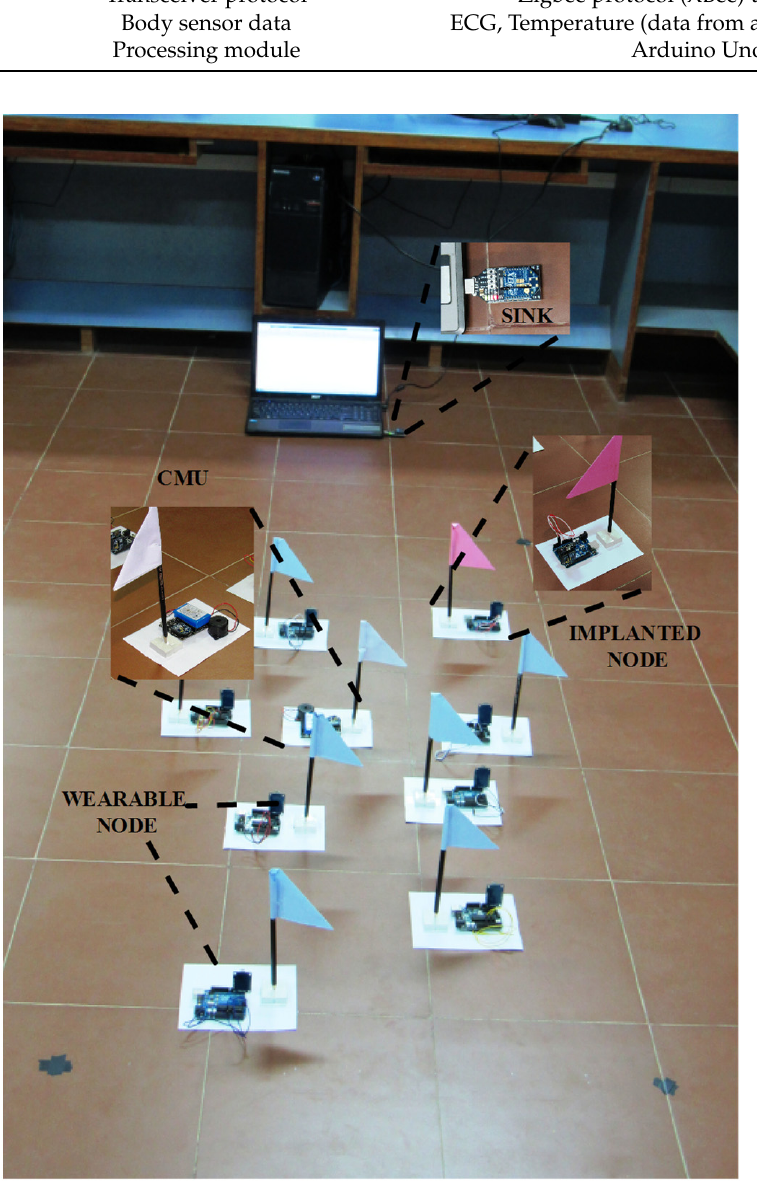
Figure 10. Experimental Setup for validation of the algorithm. The implanted node terminal voltage after 50 rounds is high in the case of the FPLE algorithm. Table 5 illustrates the protocol comparison, that the FPLE algorithm supports lifetime enhancement, emergency situations, and exhibits thermal and fault